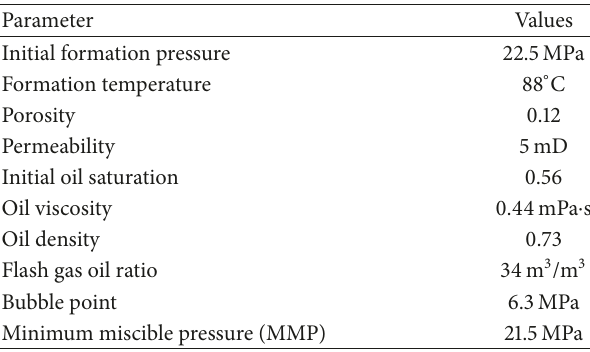
Table 1: Main parameters of the reservoir and